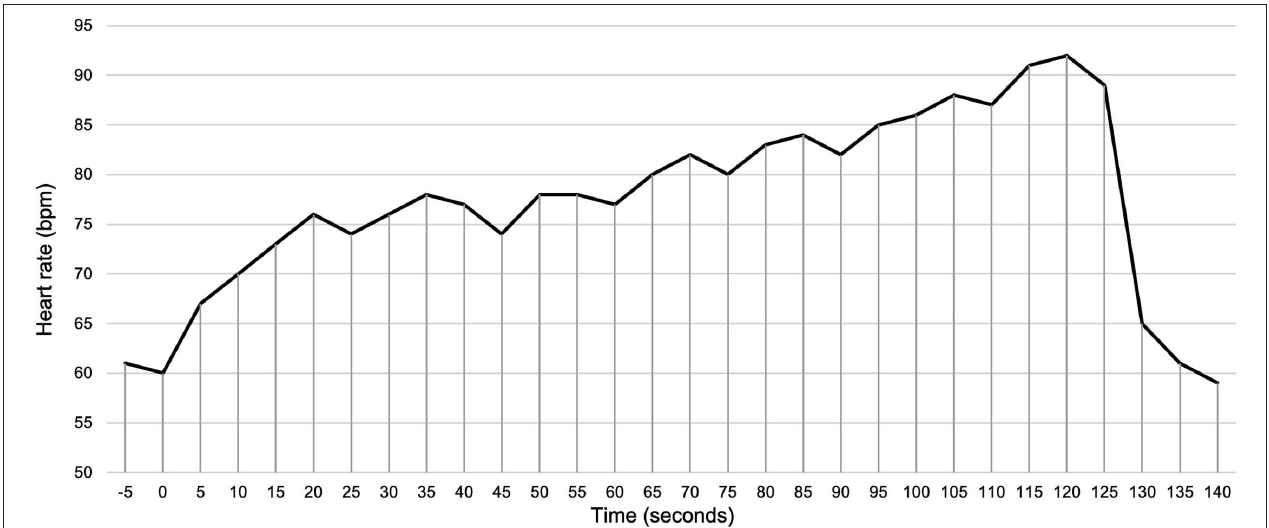
FIGURE 3 | Example of the HR response during DHE of a 29-year-old, male subject. HR increased steadily as DHE progressed. After the end of DHE (120s), HR fell rapidly toward the resting HR within 10s. DHE, dynamic handgrip exercise; HR, heart rate.